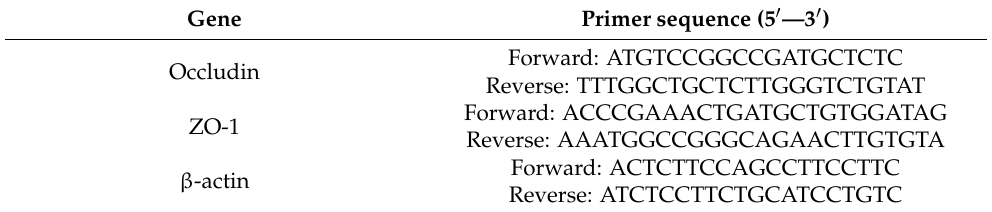
Table 1. Primer sequences for qRT-PCR.